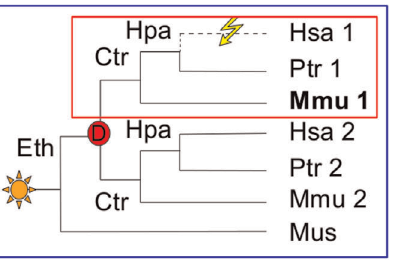
Figure 1. Approaches for detecting orthology and loss events: example of gene trees. Gene appearance detected by the phylogeny is depicted by the yellow star and the red circle represents gene duplication event. In bold is the gene used as input to build the tree. Based on the orthologous group from the Eth ancestor (blue frame) no lineage-specific loss is evidenced because each species has an ortholog to Mus. Based on the Ctr ancestor orthologous group, there are two orthologous groups, but only one group has an lineage-specific loss (red frame). Note that all abbreviations concerning species name and their ancestors are provided in Figure 6.